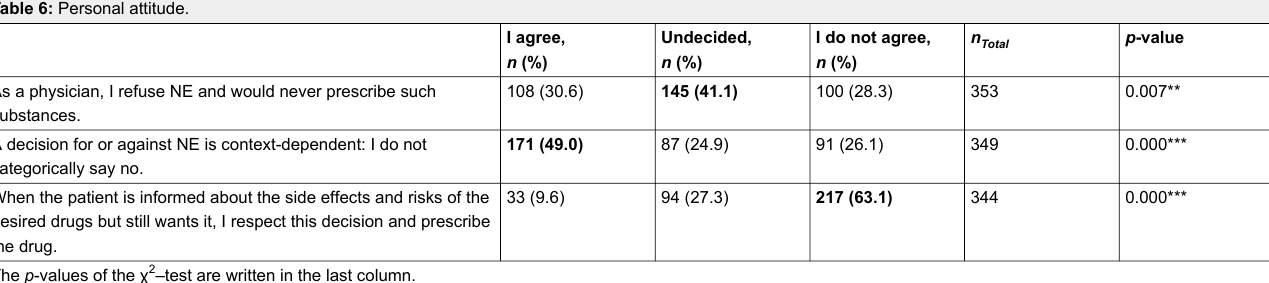
Table 6: Personal attitude.